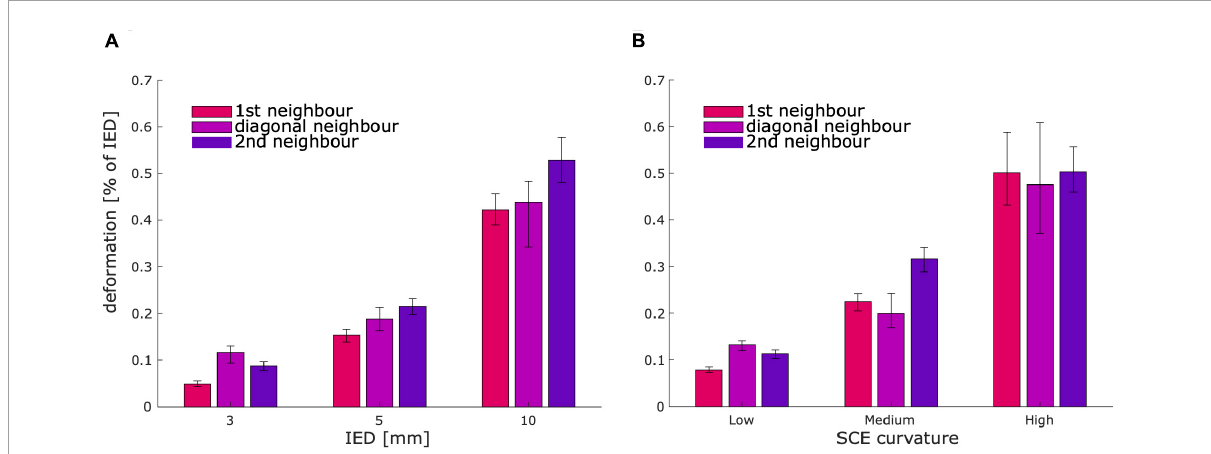
FIGURE5 Deformation between contacts for simulated grids and strips. Bar plots show that the median deformation between contacts increases with the IED (A) , and the SCE curvature (B) . As a reference, the observed deformations in real cases were an order of magnitude larger ( Supplementary Figure 3A ). Error bars denote 95% CI of the median. SCE, smooth cortical envelope; IED, inter-electrode